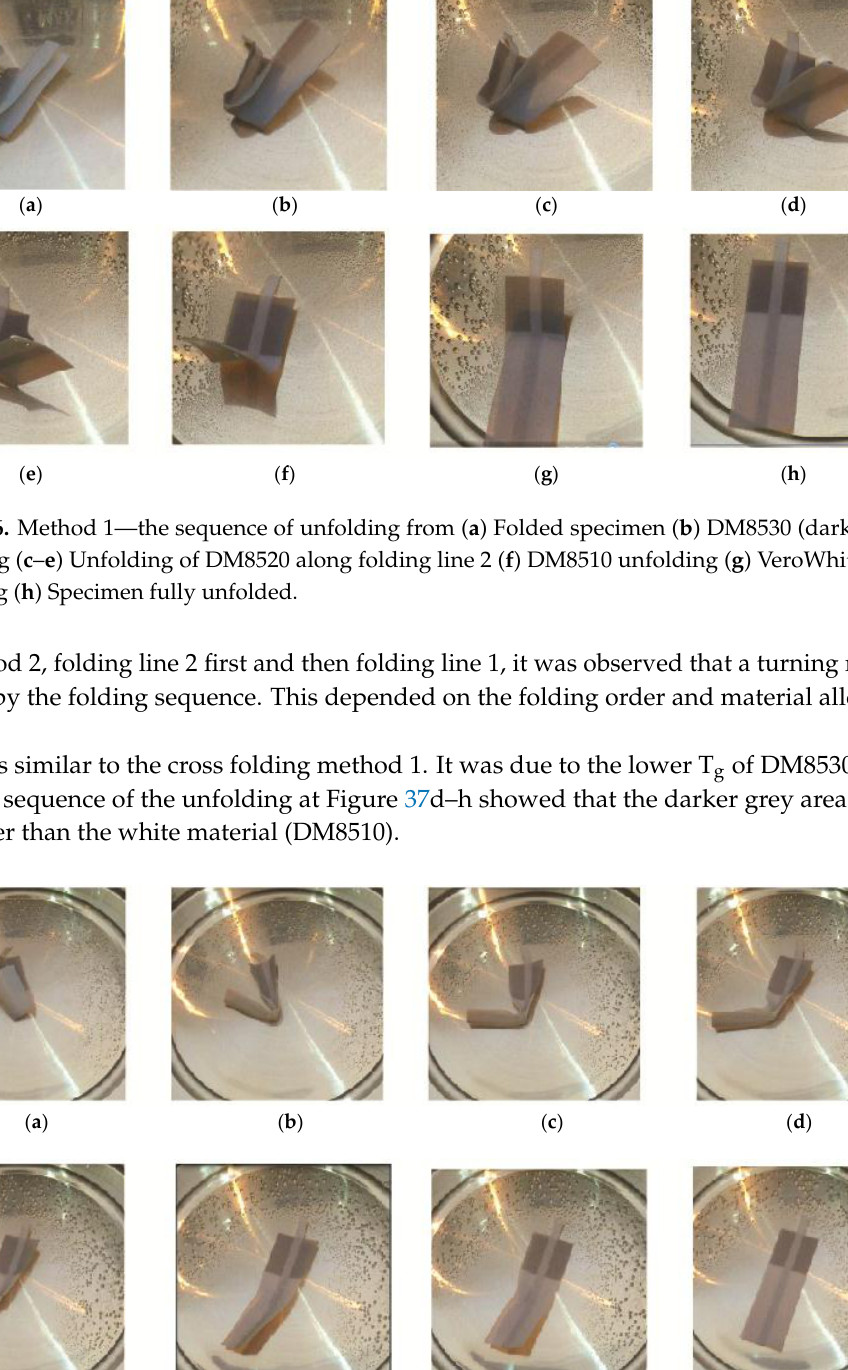
Figure 37. Method 2—the sequence of unfolding from ( a ) Folded specimen ( b ) DM8530 (dark grey) unfolding ( c , d ) DM8520 unfolding ( e , f ) DM8510 unfolding ( g ) VeroWhitePlus unfolding ( h ) Specimen fully unfolded.